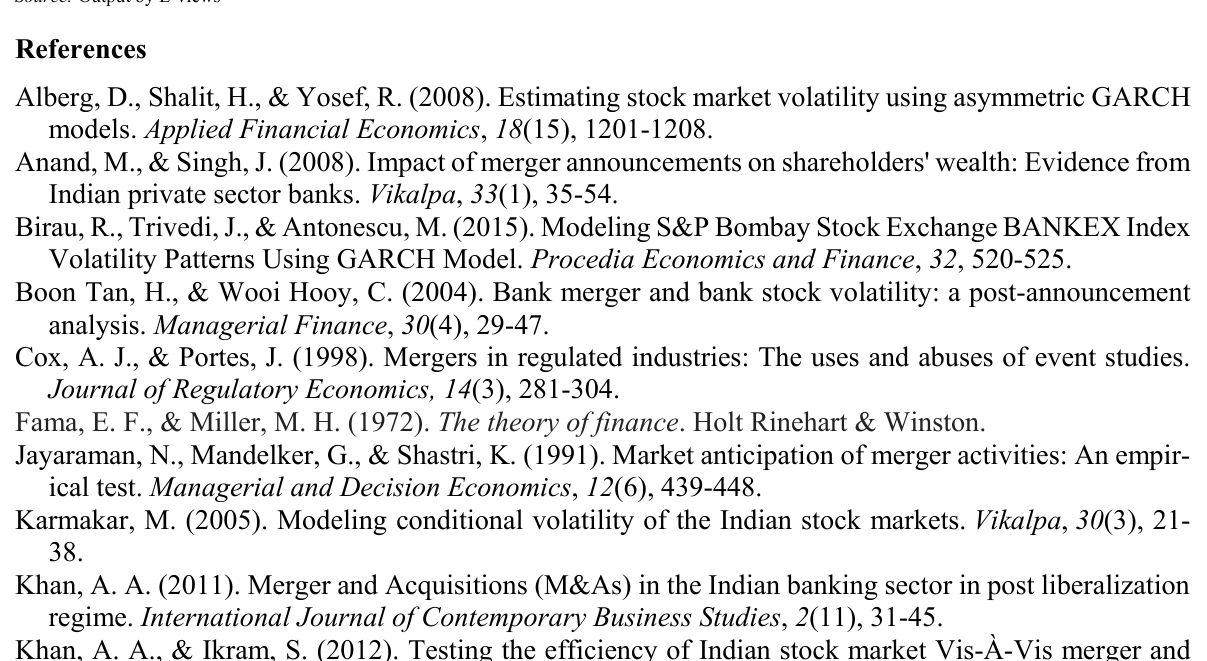
Source: Output by